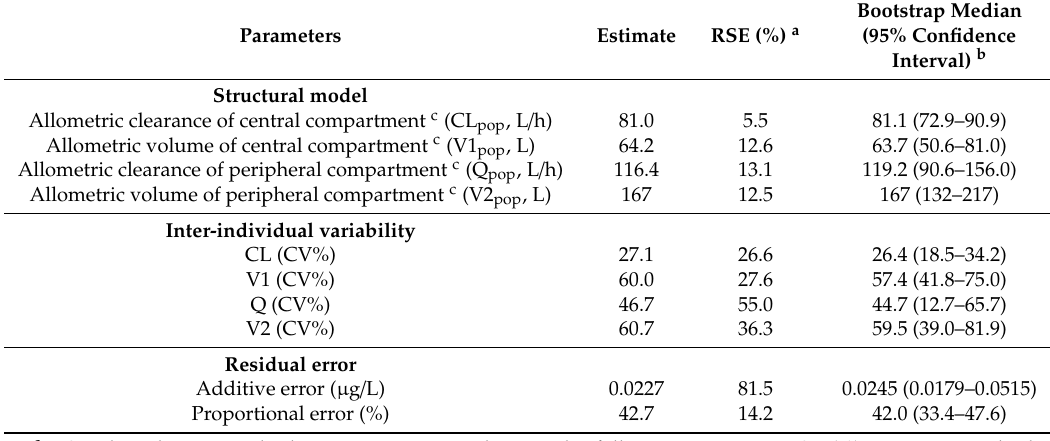
Table 2. Parameter estimates and standard error in the final population pharmacokinetic